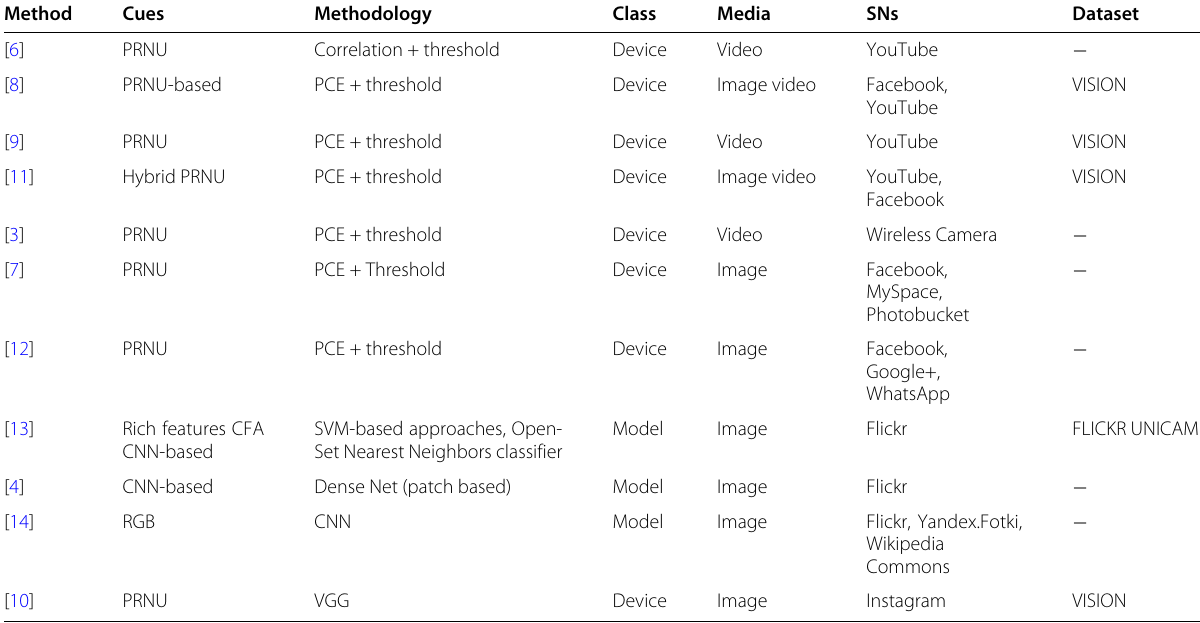
Table 2 Summary of the perfect knowledge source identification approaches